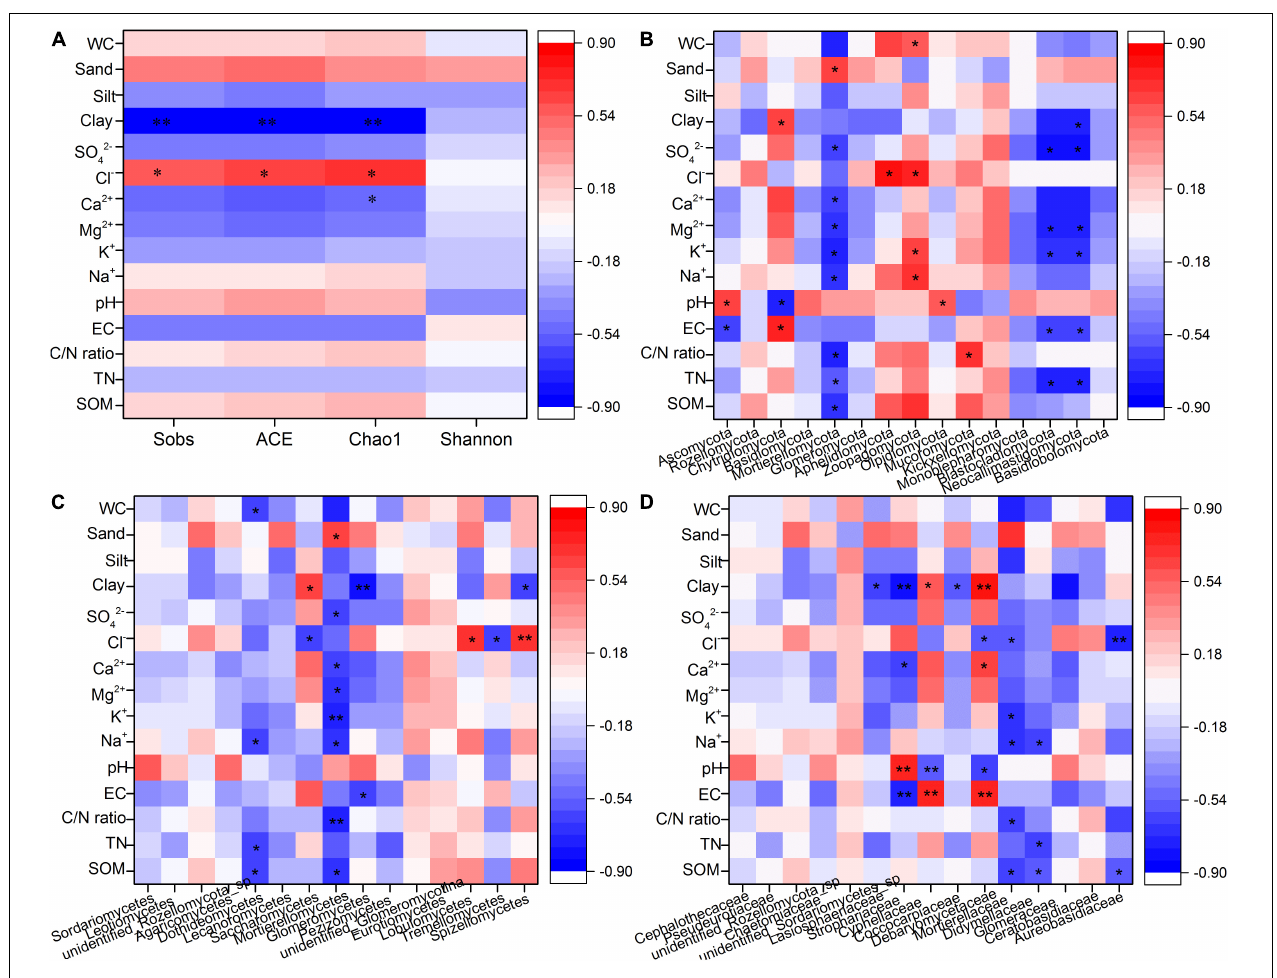
FIGURE 4 | Spearman correlation analyses between environmental variables and α diversity indices (A) , fungal community at phylum level (B) , selected fungal classes (C) , and selected fungal families (D) .